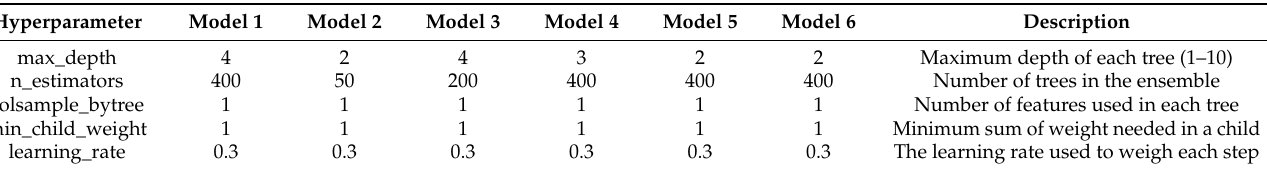
Table 1. Hyperparameters for training XGBoost